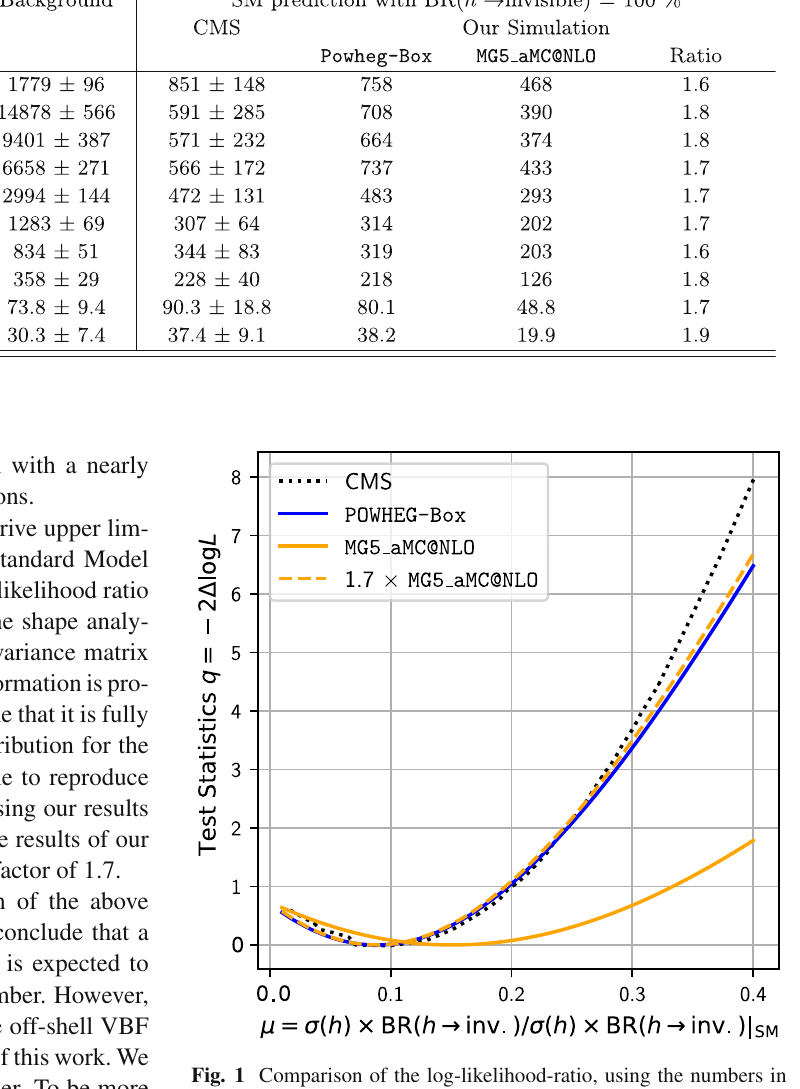
ative contributions of the latter to the total cross section become sizeable as | λ 345 | → 0. We include an invariant mass cut m jj ≥ 130 GeV and a pseudorapidity difference cut Δη jj ≥ 0 . 5 with η 1 η 2 < 0 in our parton event genera- tion. Note that these are weaker than the signal region cuts in Table